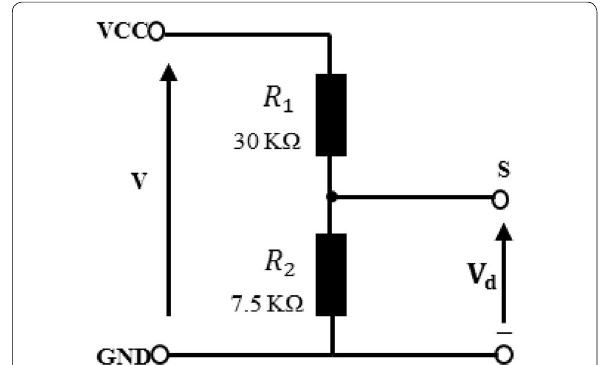
Fig. 7 Voltage divider circuit